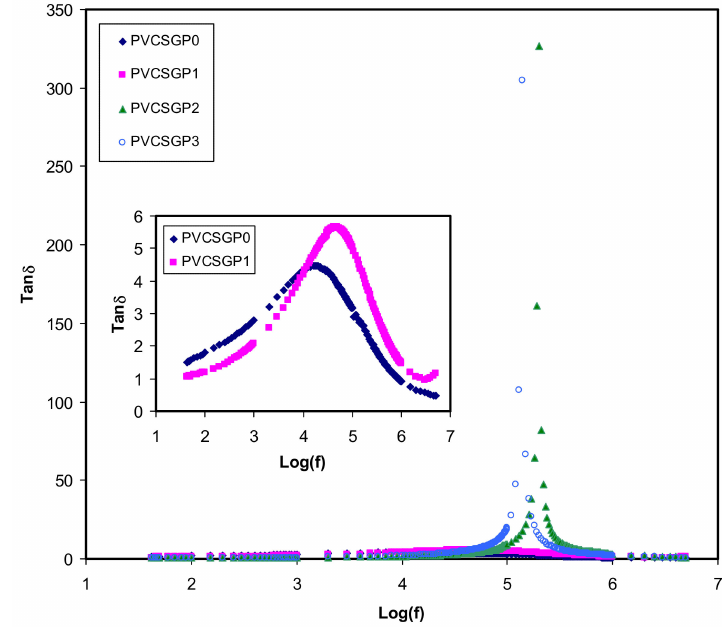
Figure 5. Tan δ versus log (f) for all polymer blend